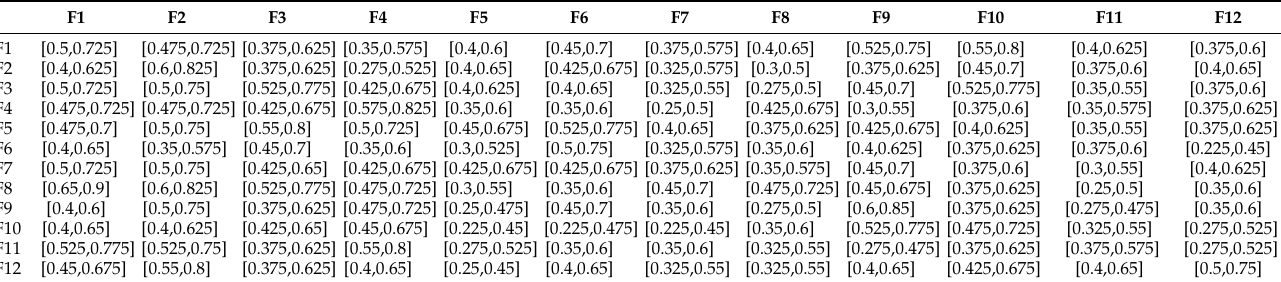
Table 8. Average grey matrix of expert evaluations.